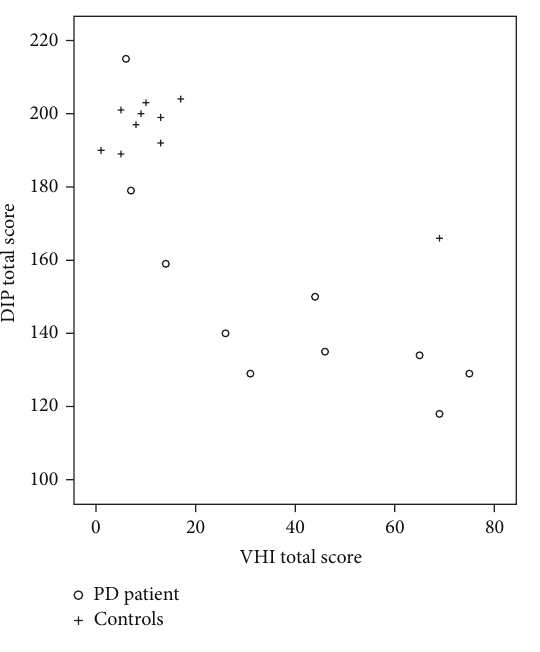
Figure 1: Voice Handicap Index (VHI) versus Dysarthria Impact Profile (DIP) total scores for the 20 participants (10 people with PD and 10 control